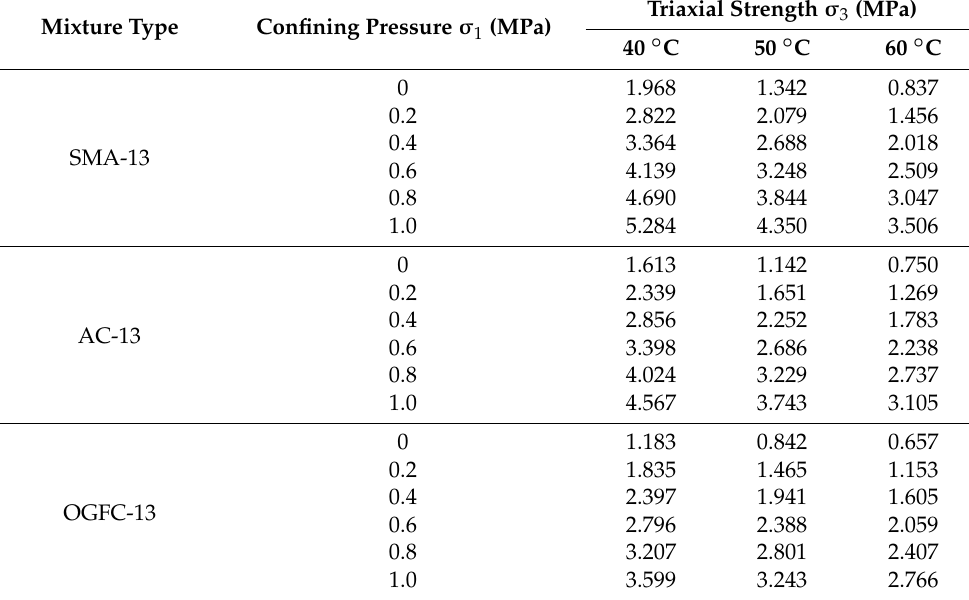
Table 3. Triaxial results of asphalt mixtures.